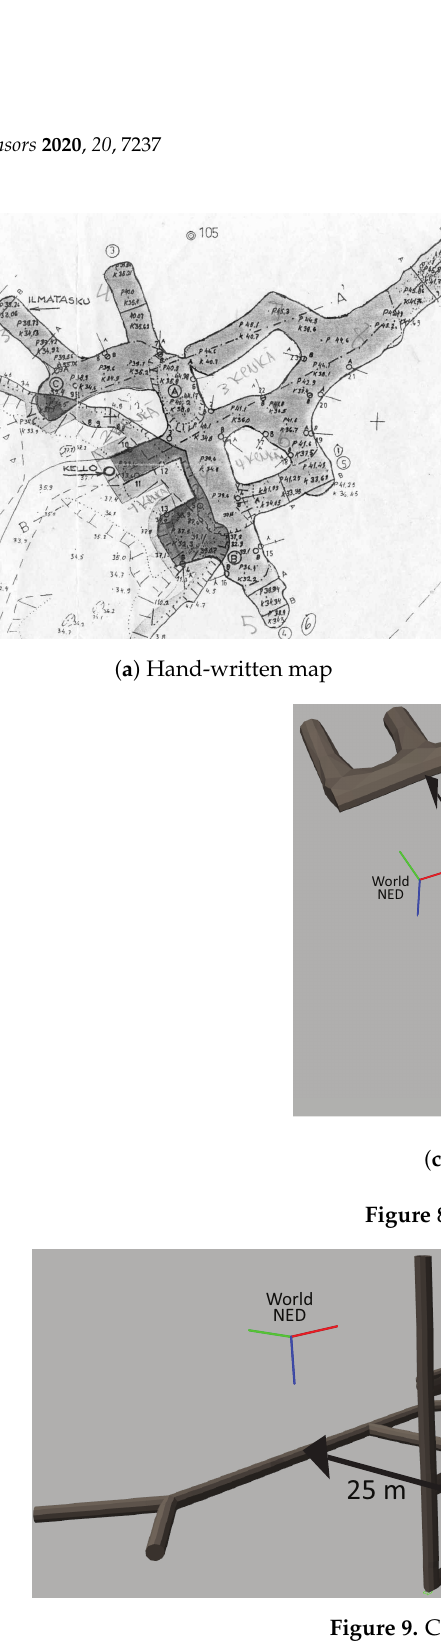
Figure 9. Complex virtual